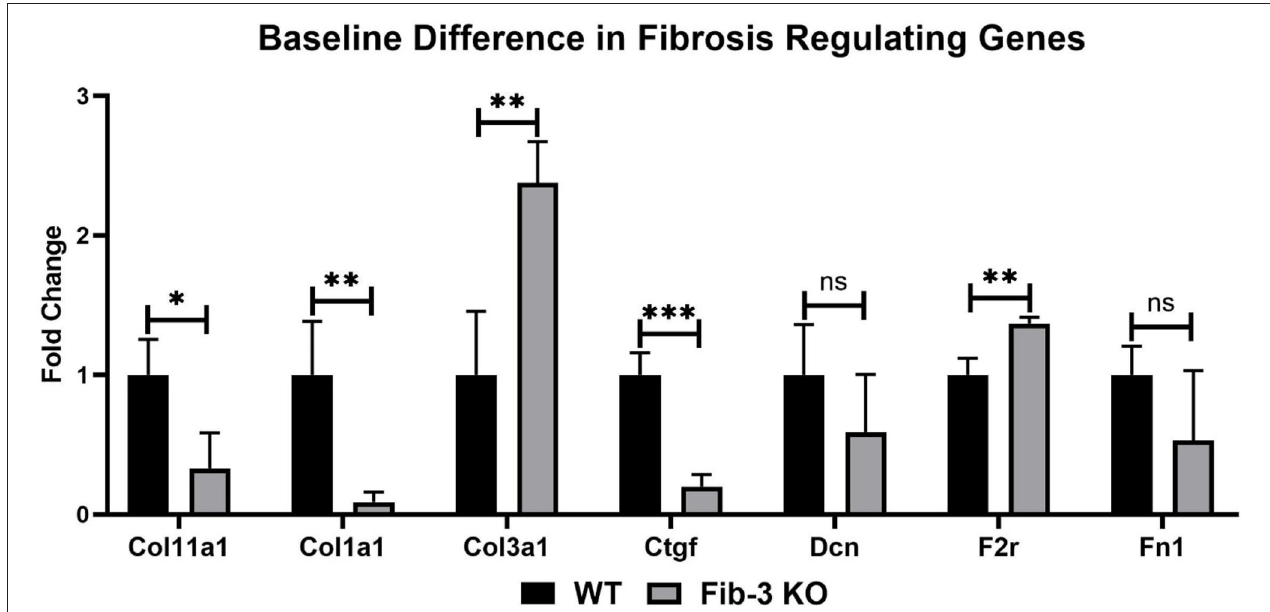
FIGURE 9 | Changes in fibrotic genes in non-infarcted WT and Fib-3 KO CSs. Relative expression of Col11a1, Col1a1, Col3a1, Ctgf, Dcn, F2r and Fn1 in WT and Fib-3 KO CSs. Unpaired t- test, p > 0.05 = ns, p < 0.05 = *, p < 0.01 = ** and p < 0.001 = ***. Error bars represent the mean ± SD ( n = 4).